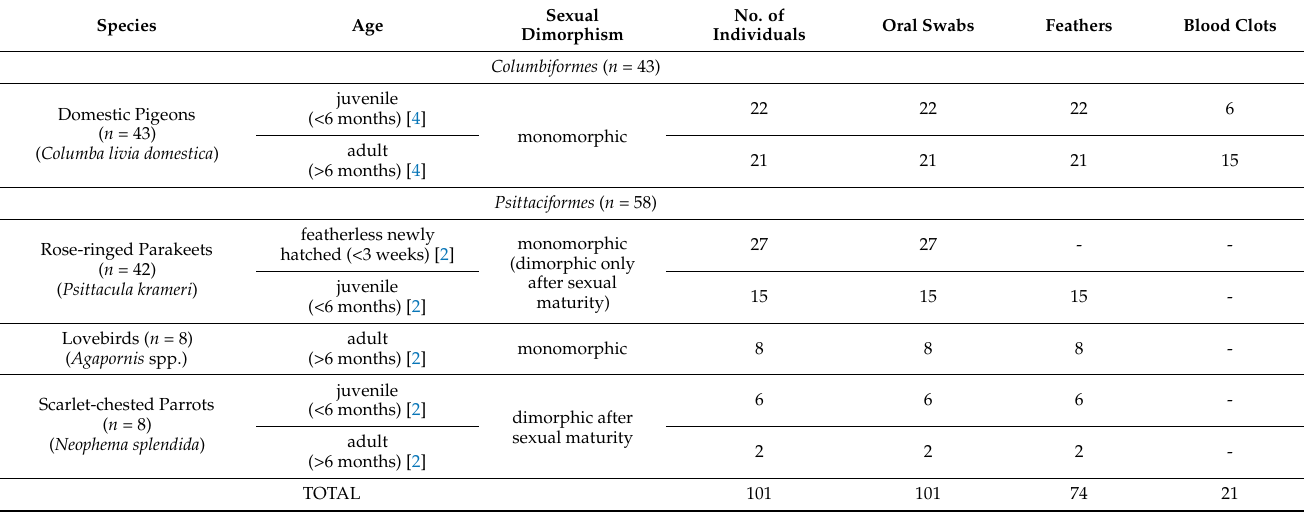
Table 2. Oral swabs and feathers collected from pet birds from five different